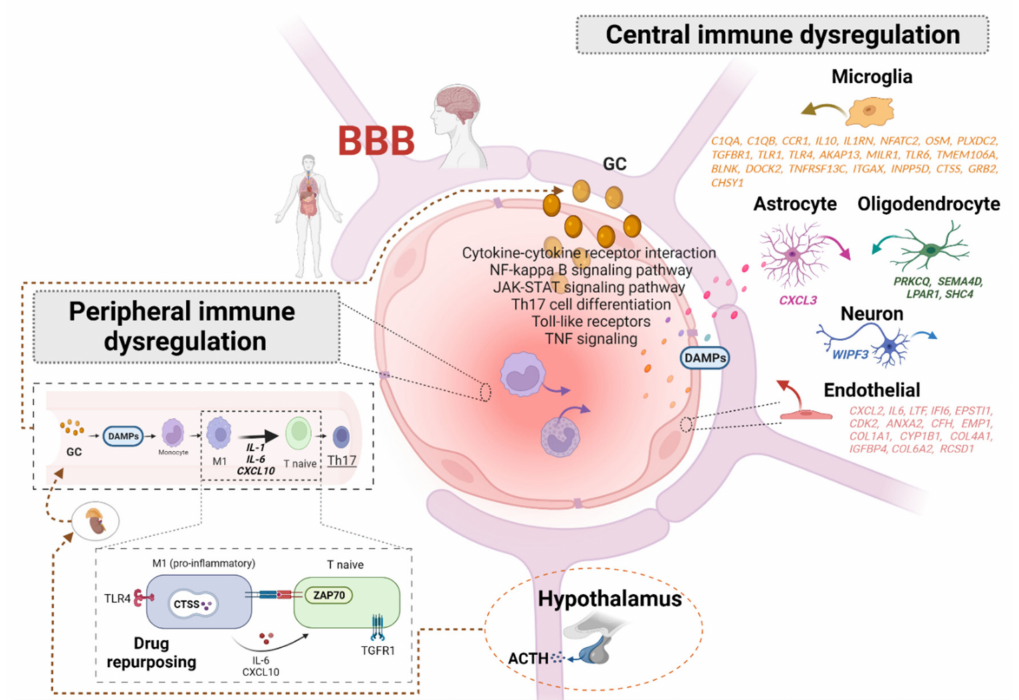
Figure 2. Depicting systematic immune response in PTSD. The immune signaling pathway is dysregulated in PTSD at multiple regulatory levels. Recent whole genome analysis in PTSD conducted on both human and animal models of PTSD have demonstrated that epigenomic and transcriptomic changes may mediate the development, maintenance, and clinical presentation of PTSD. HPA axis releasing ACHT stimulates cortisol (human (GC) glucocorticoids) production which, in turn, also mediates gene expression and exacerbates immune response in the periphery and brain. In this review, 84 genes that participate in immune signaling processes were commonly reported as differentially expressed or methylated genes in central (brain) and peripheral (such as blood and saliva) tissues across species. ~50% of those convergent genes correspond to brain-cell type specific markers such as astrocytes and microglia, which are discriminated by color. Upon inflammatory response, the blood brain barrier (BBB) may be affected and allow a higher migration of molecules crossing the brain and periphery. Thus, based on the literature review, we propose the existence of common regulatory markers able to cross BBB, impact the expression of those 84 convergent genes and orchestrate systemic immune dysregulation in PTSD through important immunological pathways such as cytokine-cytokine interaction, TNF and NF- κ B/JAK/STAT signaling. These common regulatory markers may correspond to damage-associated molecular patterns (DAMPs) which are released from damaged cells and activate the innate immune response. By using drug repurposing analysis, we also suggest that Th17 differentiation may be a possible target mechanism for drug action, as well as Toll-like receptor signaling and cytokine-cytokine receptor interaction, for the treatment of